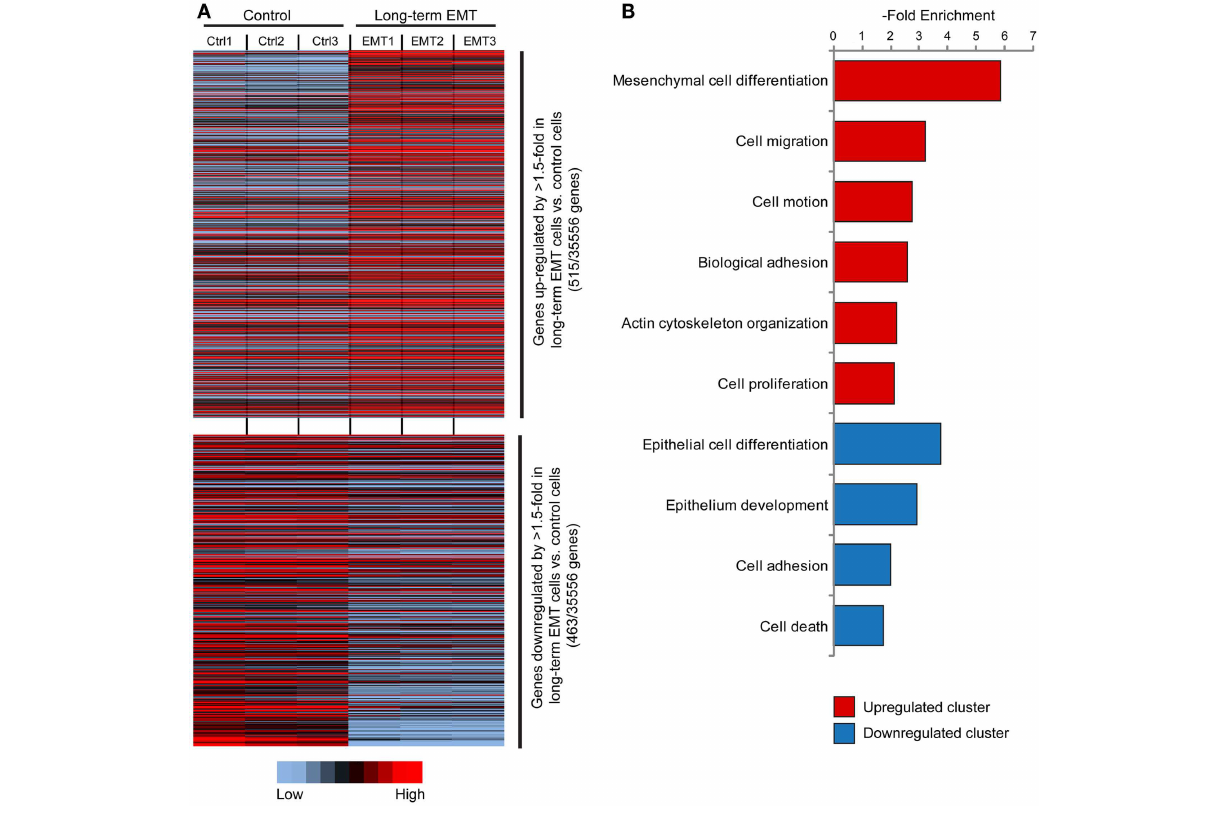
FIGURE 2 | Gene expression profiling of long-term EMT cells . (A) Heat map showing genes significantly ( P ≤ 0.05) upregulated (515 genes, upper part) or downregulated (463 genes, lower part) by > 1.5-fold in long-term EMT vs. control EpRas cells. (B) Results from cluster analysis of genes significantly upregulated or downregulated in long-term EMT